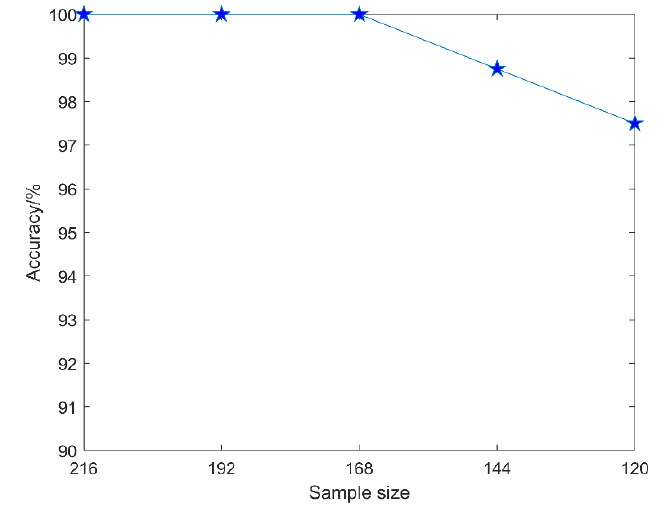
Figure 13. Graph of changes in evaluation results for different sample sizes.